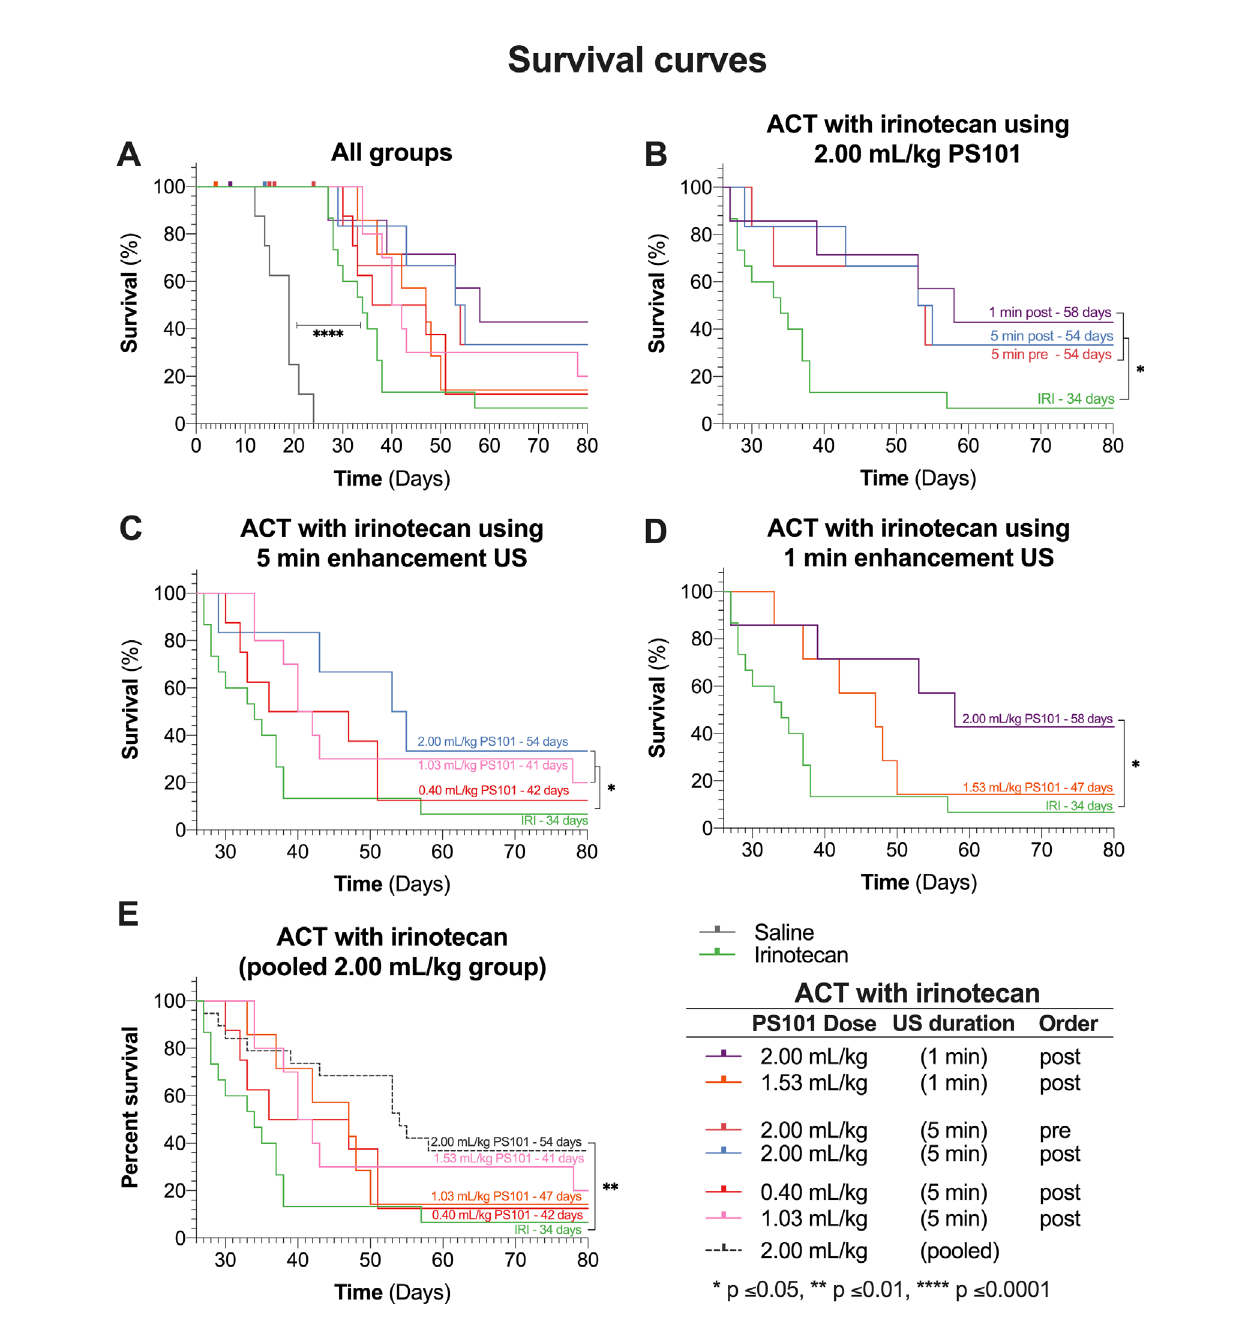
FIgURe 4 | Survival curves of all groups in the study. Each panel shows a subset of the data, each for chosen to allow specific comparisons. The labels on the survival curves indicate the groups and the median survival. (Panel A ) shows the survival curves of all the groups in the study. Mice that did not complete the full 28 days of treatment are marked as censored subjects. (Panel B ) compares results for various enhancement-US durations and whether PS101+US was administered pre-irinotecan or post-irinotecan, for mice that received 2.00 ml/kg PS101. (Panel C ) shows the survival curves of the dose response study for groups that received ACT with irinotecan with 5-min enhancement US at three doses. (Panel D ) shows the survival curves of mice that received PS101 and US post-irinotecan with one min of US enhancement at two different PS101doses. (Panel e ) pools all the mice that received 2.00 ml/kg PS101 and compares the survival curve to those for the other ACT with irinotecan groups and irinotecan